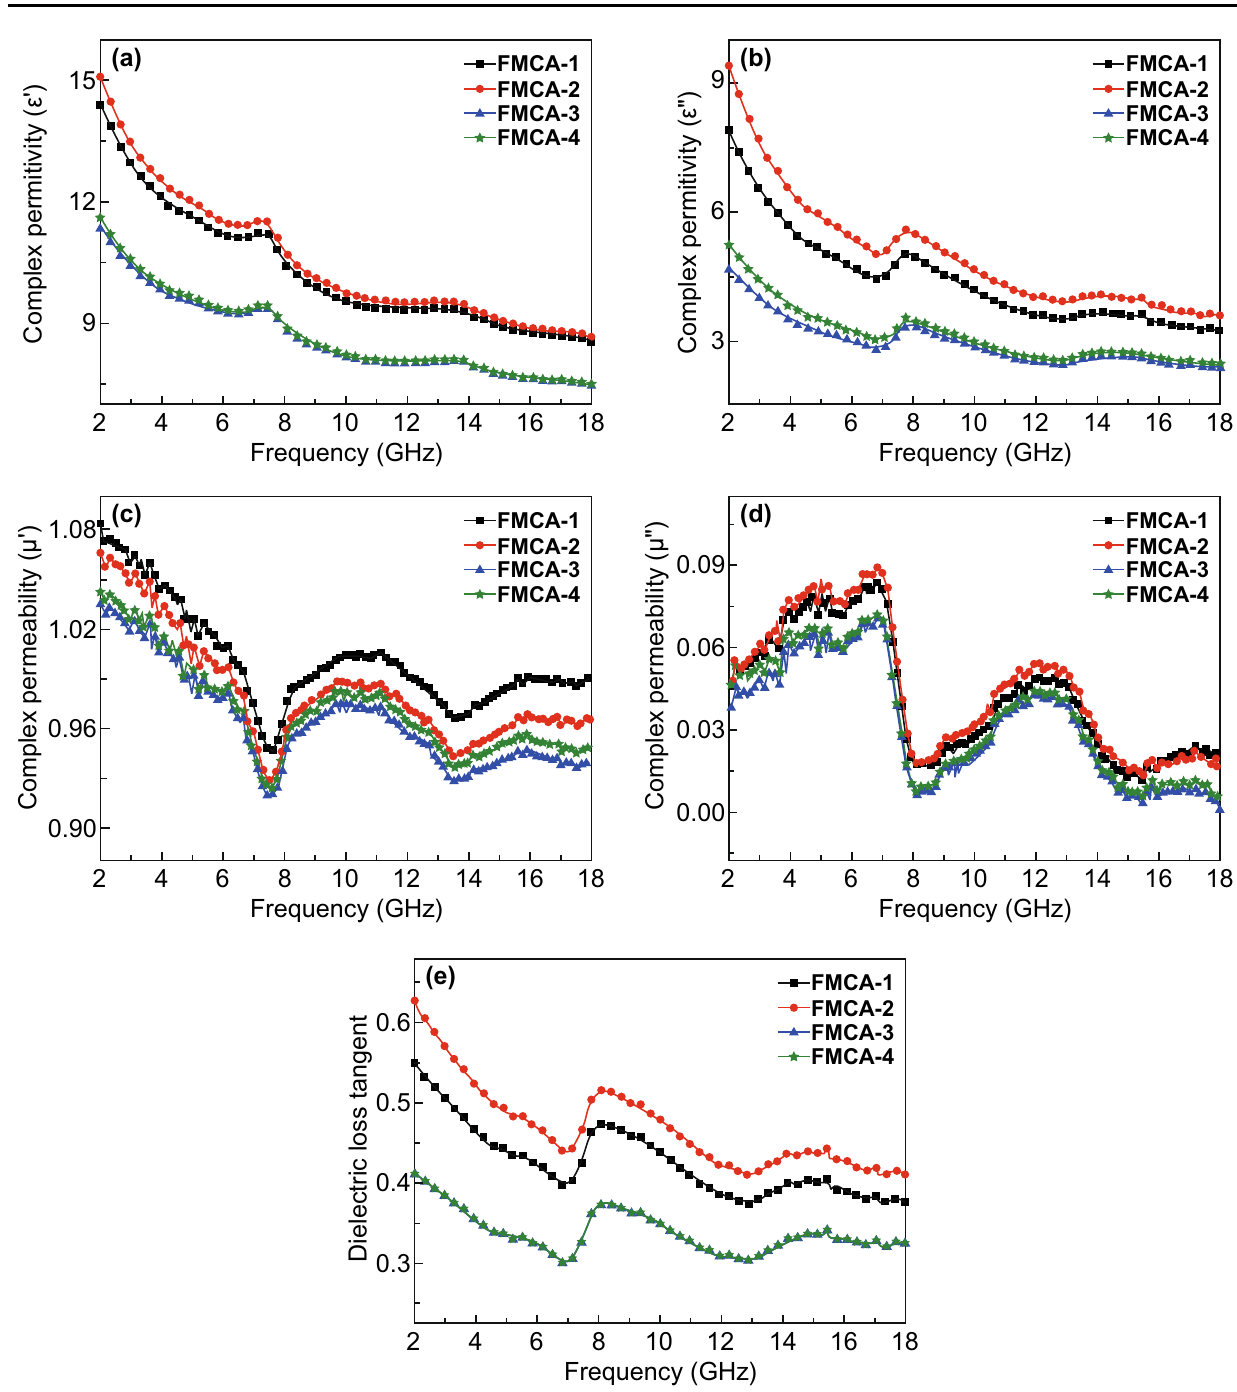
Fig. 6 Electromagnetic parameters of FMCA: a real part ( 𝜀 ′ ) , b imaginary part ( 𝜀 ′′ ) of permittivity, c real part ( 𝜇 ′ ), d imaginary part ( 𝜇 ′′ ) of permeability, e dielectric loss